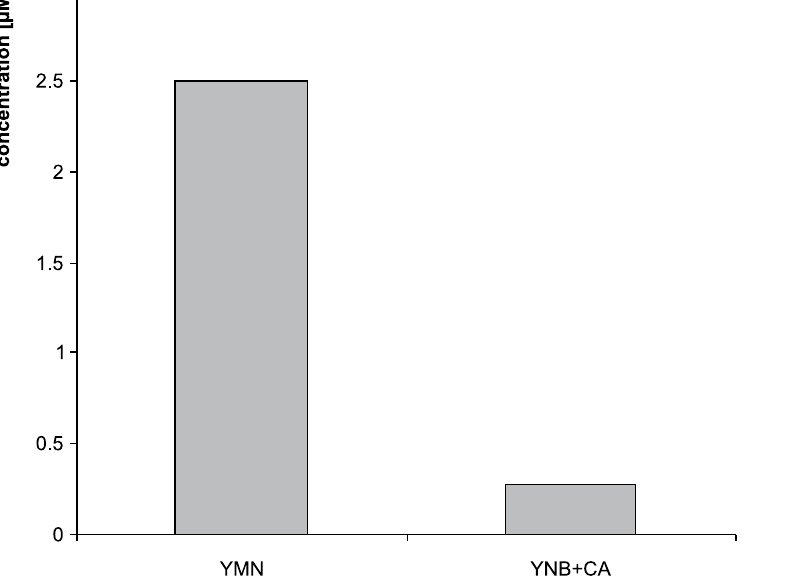
Fig. 4. Viability of Trichosporon cutaneum cells in the presence of C14 compound and ami-